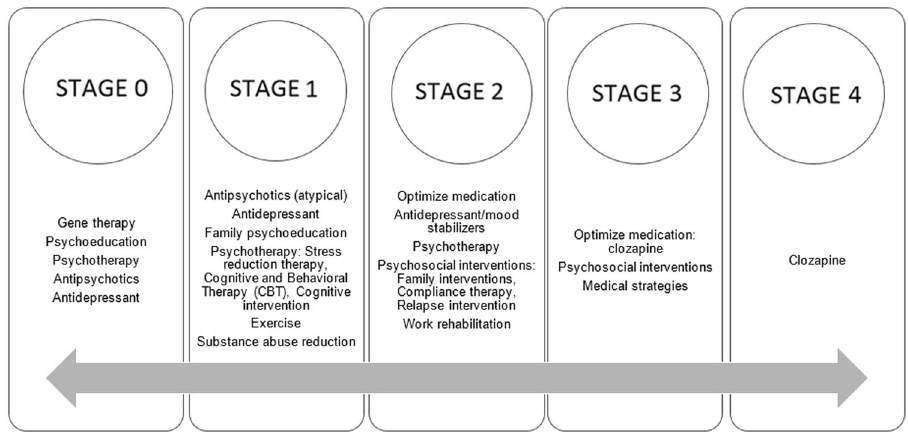
Fig. 2 Interventions proposed by